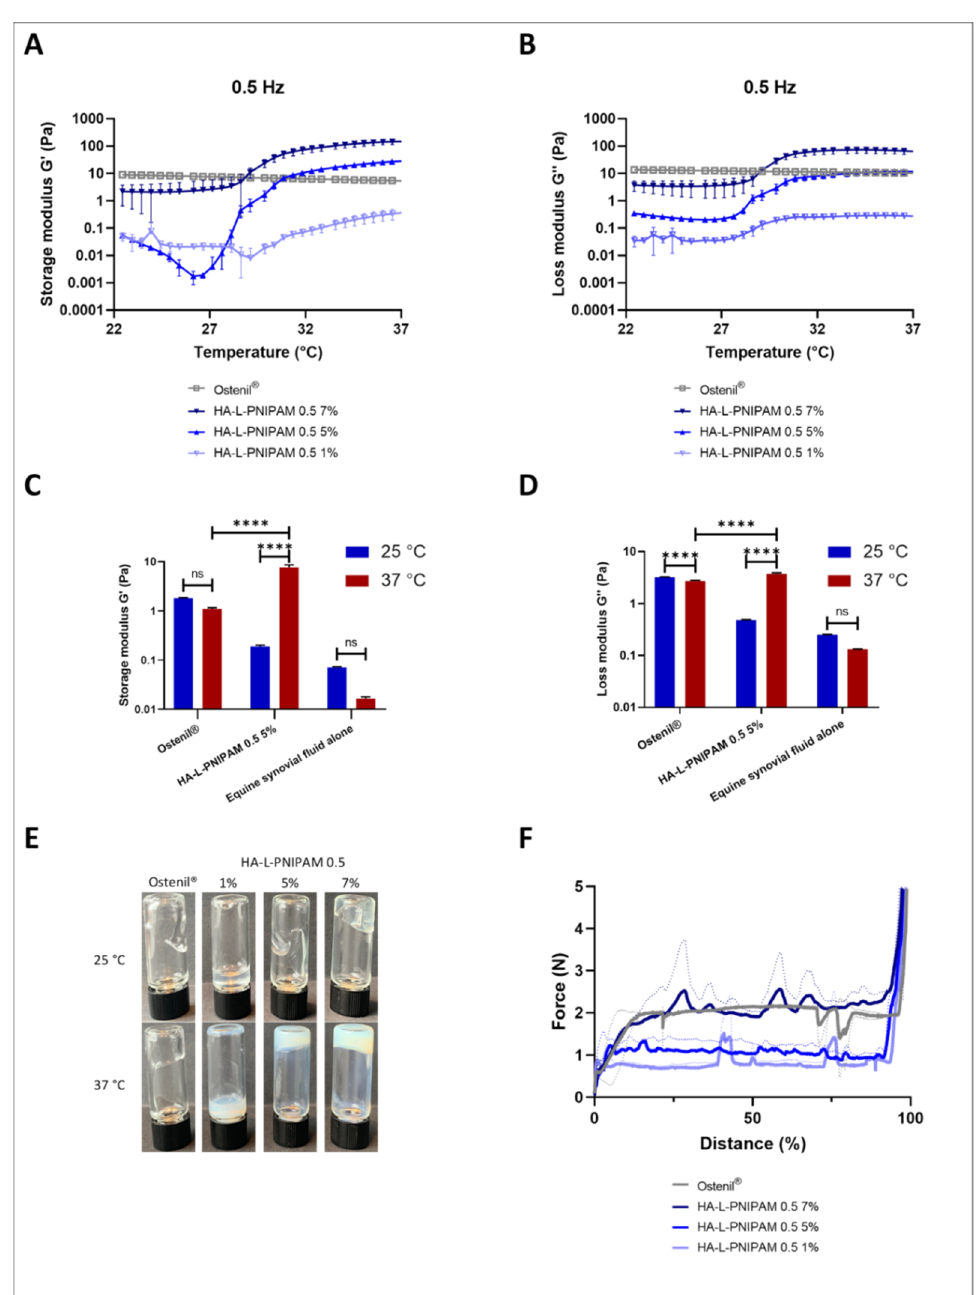
Figure 3. Temperature dependence of the storage modulus (G ′ ) and loss modulus (G ″ ) at a frequency of 0.5 Hz of Ostenil ® , HA-L-PNIPAM 0.5 1%, 5%, and 7% ( n = 3; ± sd) ( A , B ). Storage modulus G ′ ( C ) and loss modulus G” ( D ) of Ostenil ® and HA-L-PNIPAM 0.5 5% mixed with equal volumes of equine synovial fluid and equine synovial fluid alone at 22 ◦ C and 37 ◦ C at a frequency of 0.5 Hz. Highly statistically significative differences (i.e., p < 0.0001) were evidenced by four asterisks (“****”) ( n = 3; ± sd) ( C , D ). Picture of Ostenil ® , HA-L-PNIPAM 0.5 1%, 5%, and 7% at 25 ◦ C and 37 ◦ C after a 180 ◦ flip of the vial, and 15 s delay ( E ). Force in Newtons (N) required to extrude Ostenil ® , HA-L-PNIPAM 0.5 1%, 5%, and 7% as a function of the stroke distance of the piston in a syringe with a 23G needle (distance %) at 22 ◦ C ( n = 2; ± sd) ( F